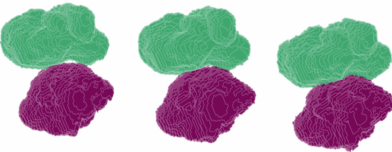
Figure 6. 3D rendering of two grains in contact. From left to right, t = 0h, t = 48h and t = 96h. The grains swelled during the high RH exposition, and so they increased their contact area.